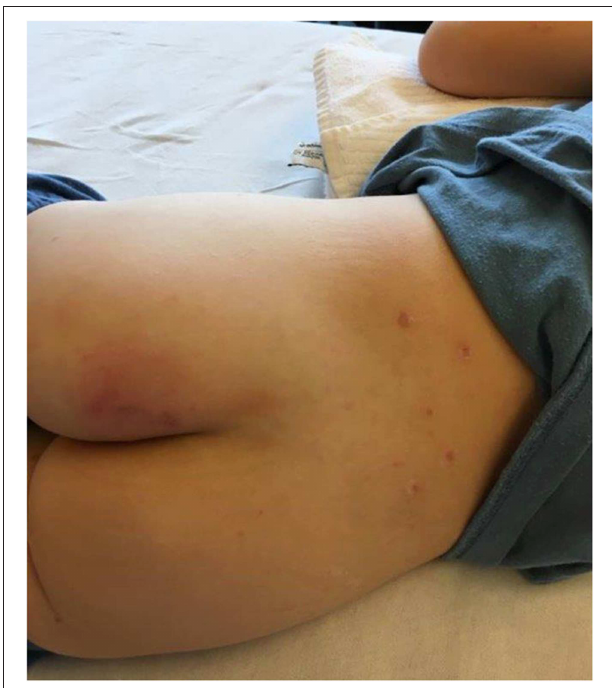
FIGURE 1 | Crusted VZV lesions (sacrum) and reddish-blue painful lesion on left